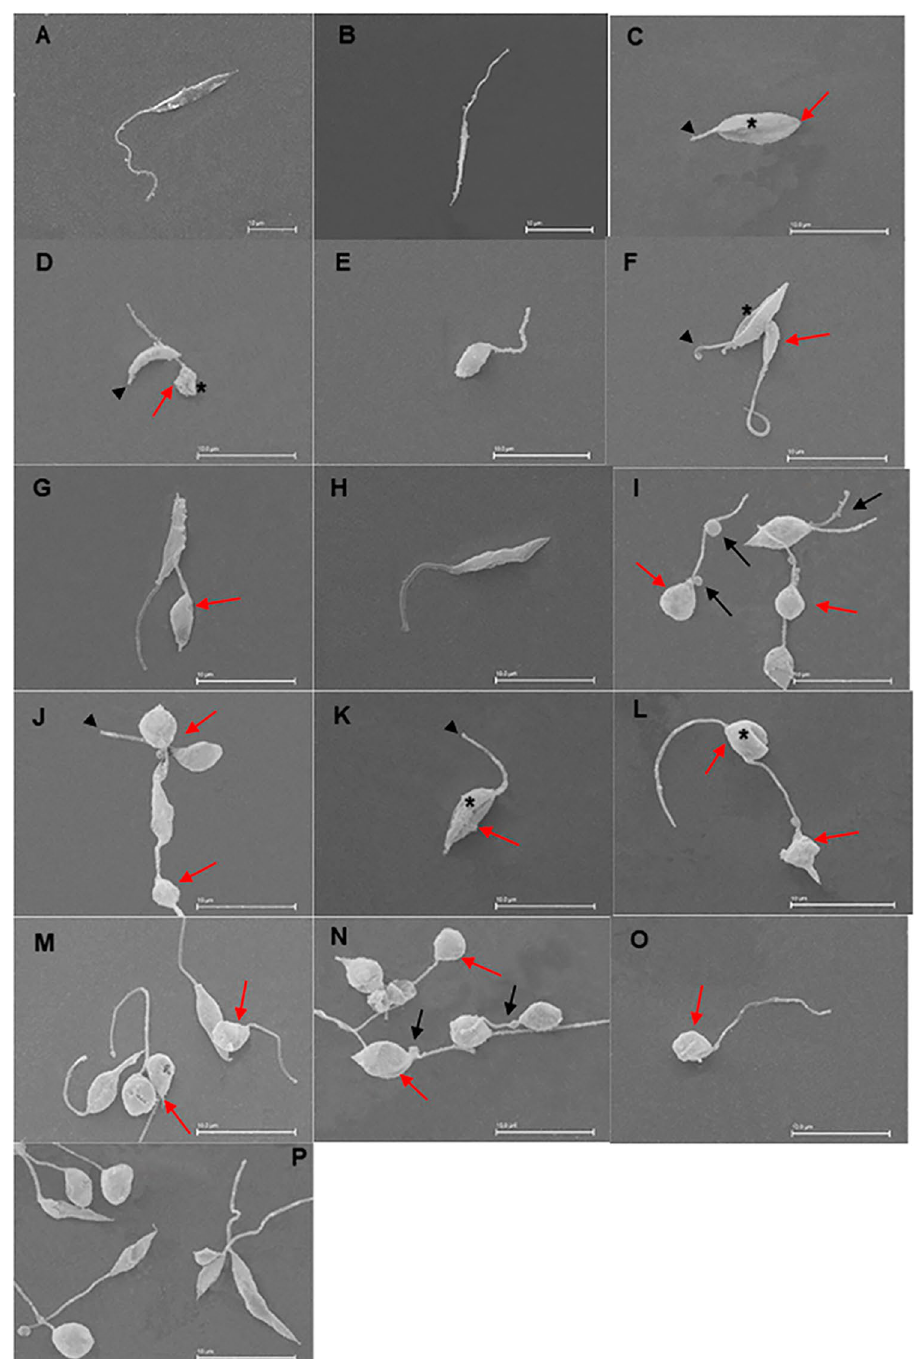
Figure 3. Ultrastructural changes in L. (L) amazonensis promastigotes treated with amphotericin B, FrDCL, SF5-6, SF8 and SF9 obtained from Aspidosperma nitidum bark. ( A ) Negative control; ( B ) Solvent control; ( C , D and E ) amphotericin B: 0.1953 µg/mL, 0.09765 µg/mL and 0.048825 µg/mL, respectively; ( F , G and H ) FrDCL: 50 µg/mL, 25 µg/mL and 12.5 µg/mL, respectively; ( I and J ) SF5-6: 50 µg/mL and 25 µg/mL, respectively; ( K , L and M ) dihydrocorynantheol: 25 µg/mL, 12.5 µg/mL and 6.25 µg/mL, respectively; ( N , O and P ) SF9 50 µg/mL, 25 µg/mL and 12.5 µg/mL, respectively. The arrowhead indicates a parasite with a short flagellum, a black arrow indicates protuberances in the flagellum and/or a double flagellum, the red arrow indicates a change in cell shape and the asterisk, septation of the cell body. Bars: 10